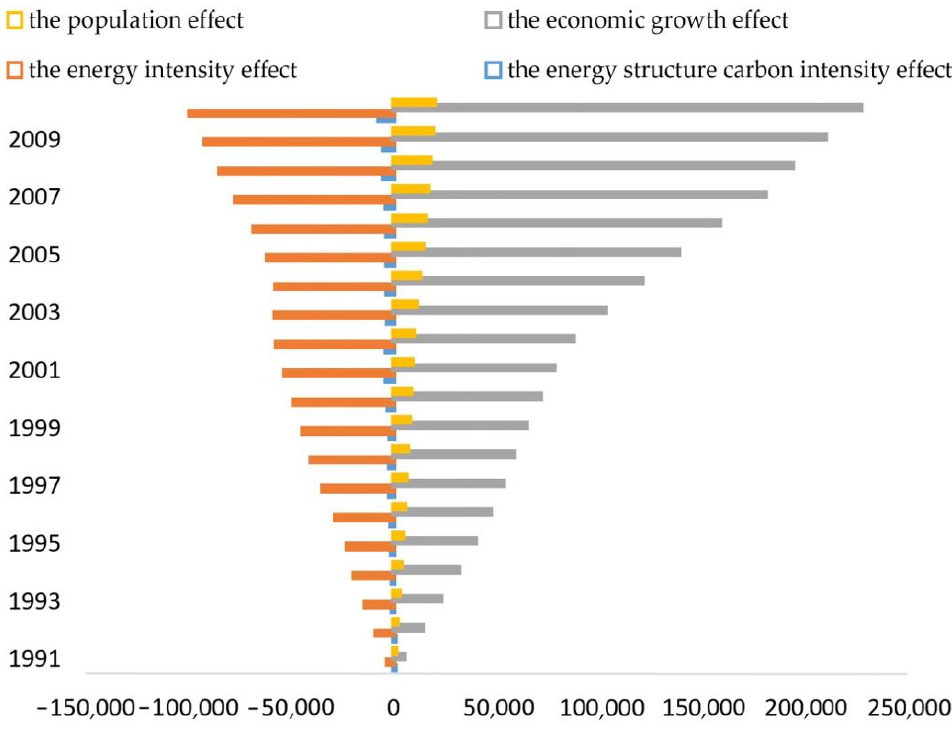
Figure 5. Contribution of each effect to carbon emissions from 1991 to